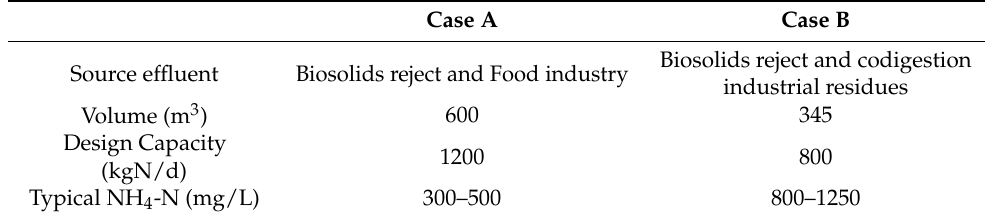
Table 3. Characteristics of the long-term NOB suppression case studies